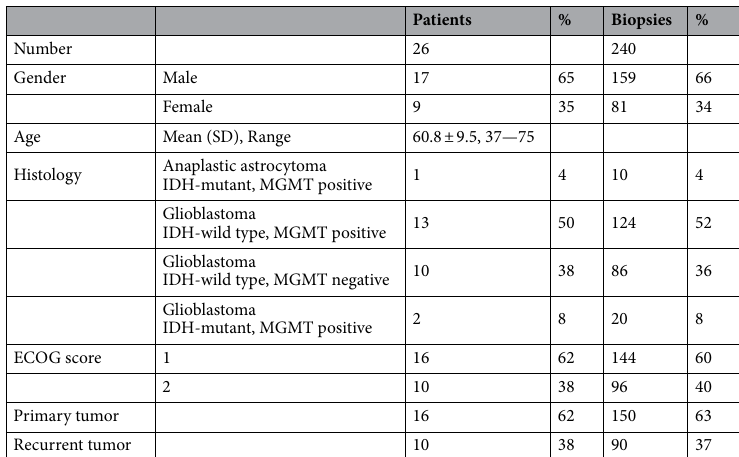
Table 1. Overview of the patient cohort 30 . Patients and biopsies were classified according to